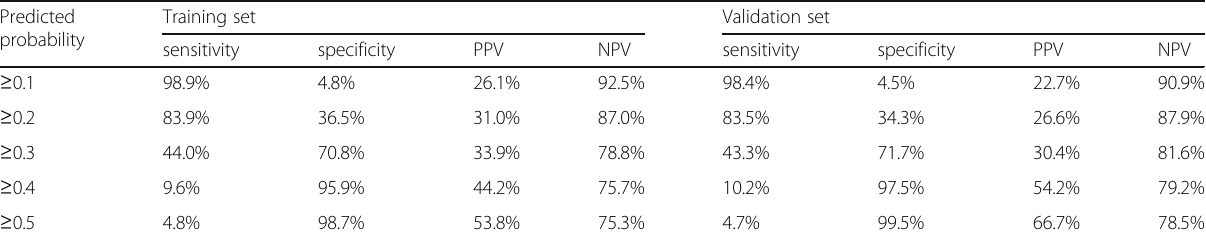
Table 3 Values of sensitivity, specificity, and predictive values of the predicted probability at different cutoff values Predicted Training set Validation set probability sensitivity specificity PPV NPV sensitivity specificity PPV